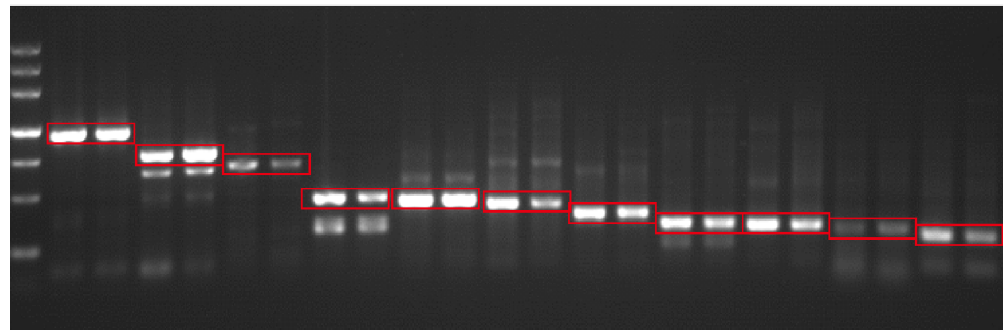
Figure 5. Transcription detection of 11 candidate orfs in AL18A and F 1 . M, molecular marker, from bottom to the upper, 200, 500, 800, 1200, 2000, 3000, 4500 bp, respectively; 1–11 represented 11 candidate orfs ( orf376 , orf279 , orf232 , orf139 , orf129 , orf124 , orf103 , orf85 , orf83 , orf74 , and orf66 ) in AL18A and F 1 (AL18A × 99AR144-1), S represents AL18A, and F represents F 1 (AL18A × 99AR144-1).